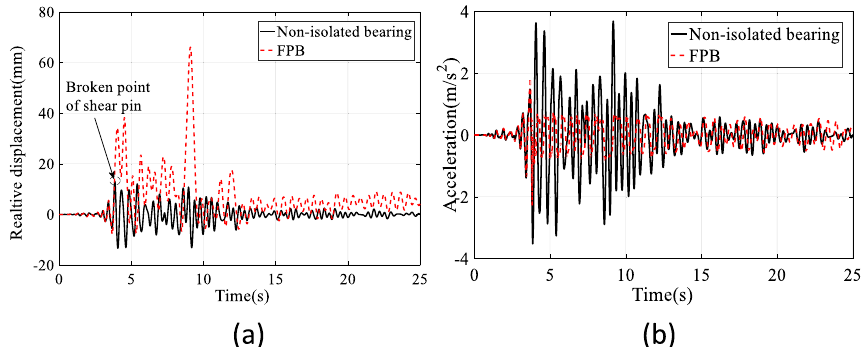
Fig. 21 Response of bridge deck undergoing No.1 ground motion: a relative displacement of the bridge deck; and b acceleration of the bridge